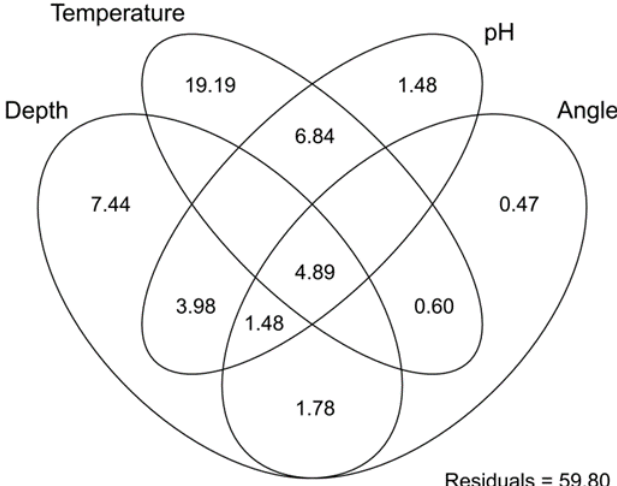
Figure 6. Venn diagram of variance partitioning analysis illustrating the percentage of variance in the testate amoeba assemblage data explained by sampling depth, temperature, pH, and lakebed angle of inclination. Values show percentages of the variance explained by each variable and joined effects of their interaction (computed from adjusted R 2 ). The analysis is based on the results of redundancy analysis (relative abundance data, covariance matrix). The significance of the testable fractions is given in Table 2. Values less than zero are not shown.